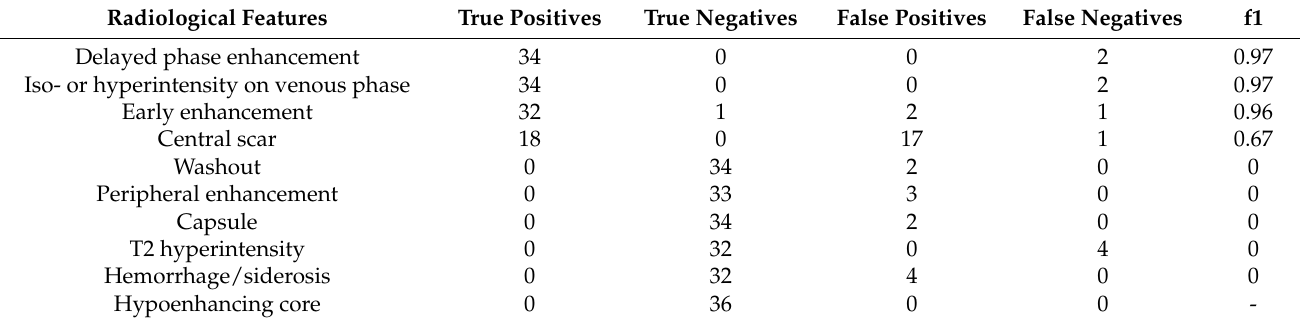
Table 4. Results for annotated features: focal nodular hyperplasia.